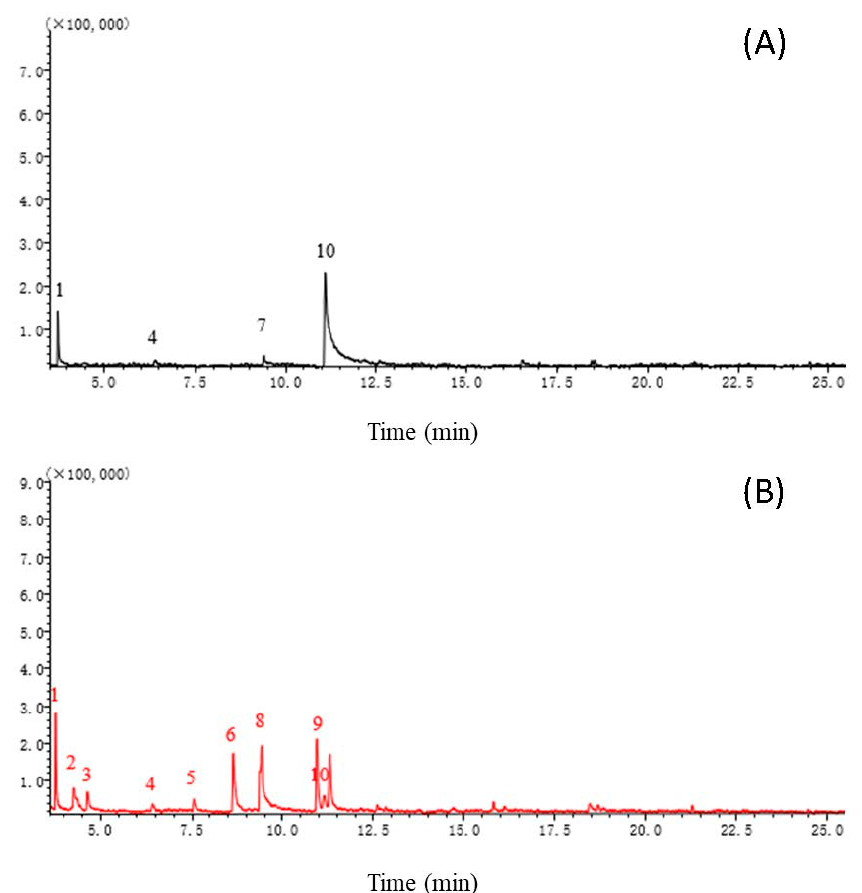
Table 1. GC/MS analysis of strain GJ-7 fermentation broth.